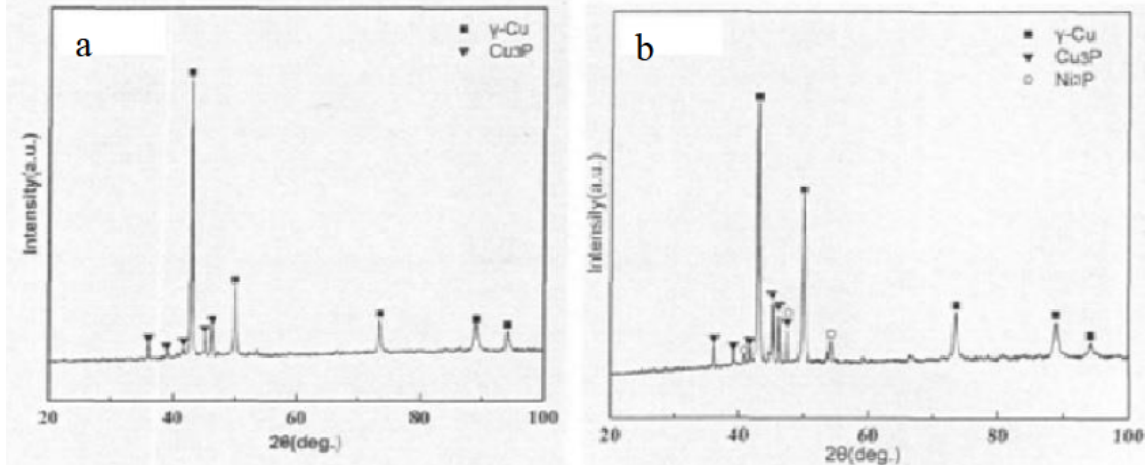
Figure 10: XRD patterns of a tensile fracture in brazing joint of the (a) amorphous and (b) crystalline brazing filler metal